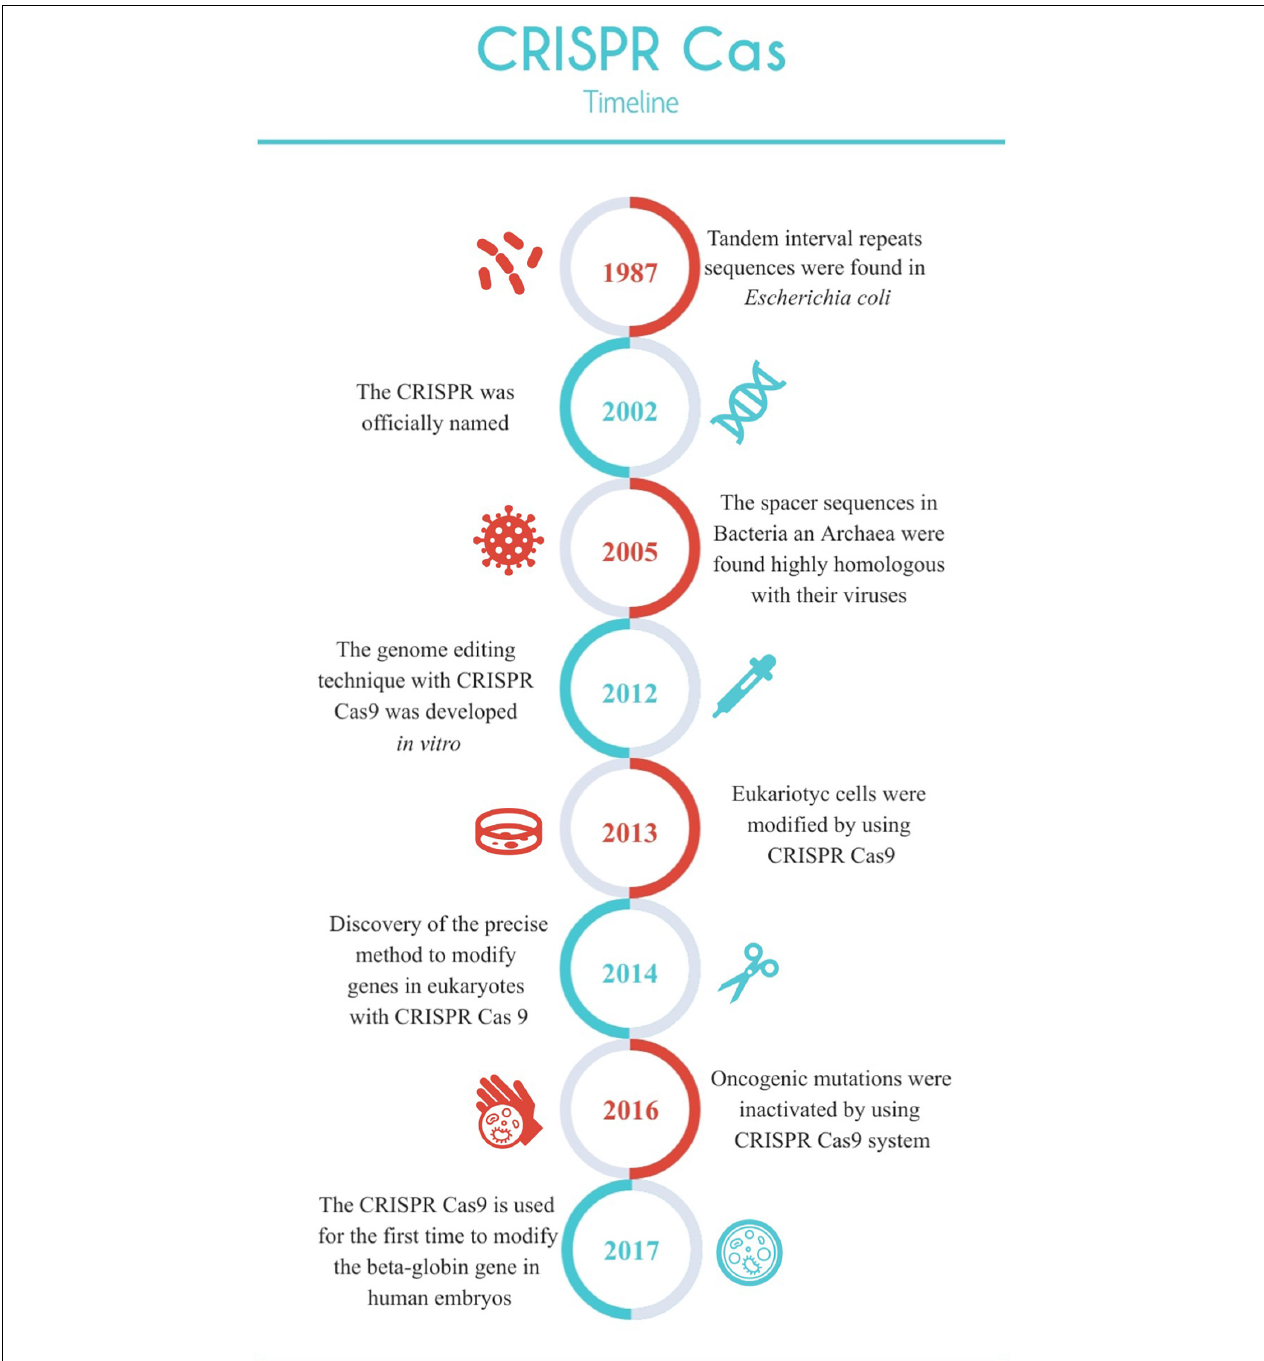
FIGURE 1 | Timeline of the most relevant discoveries about the CRISPR Cas